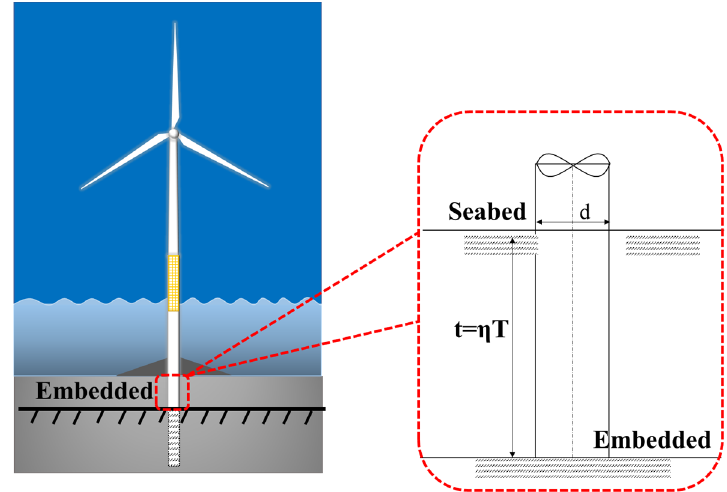
Figure 2. Hypothetical embedded point method. Table 1. Parameters of the constitutive law of